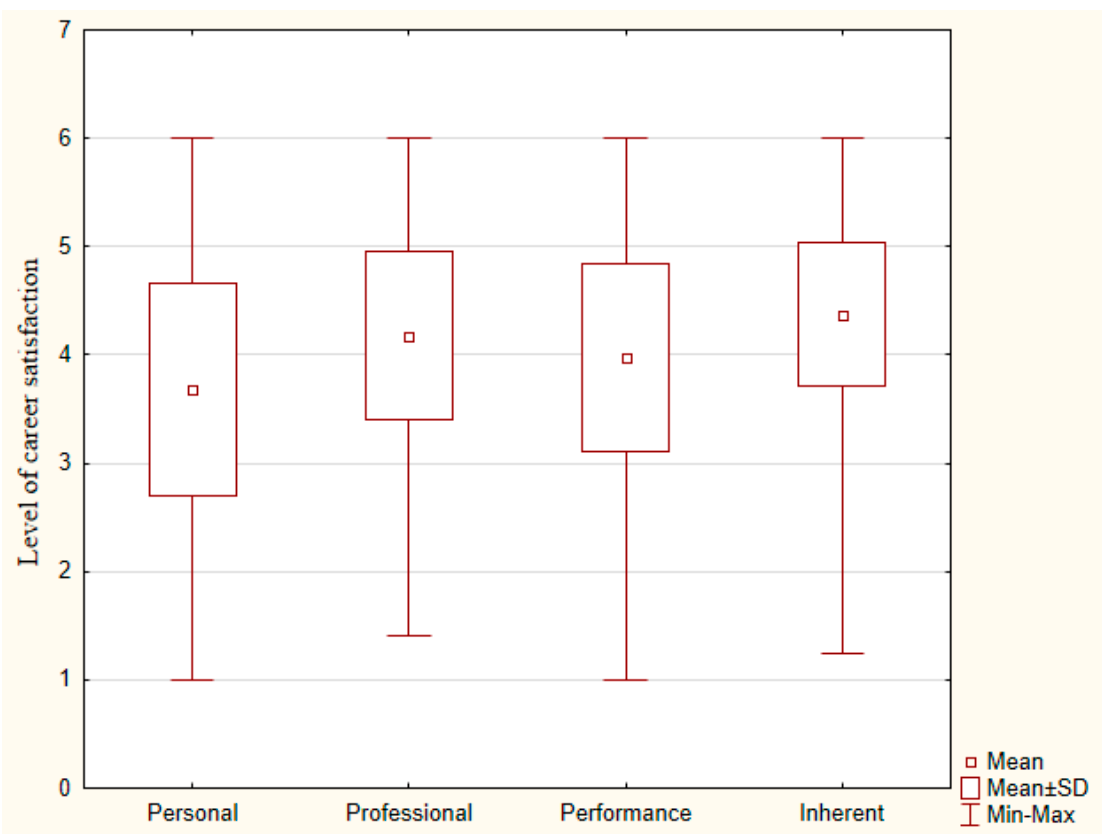
Figure 1. Levels of career satisfaction of physicians working in Polish hospitals by dimensions ( n = 1003).